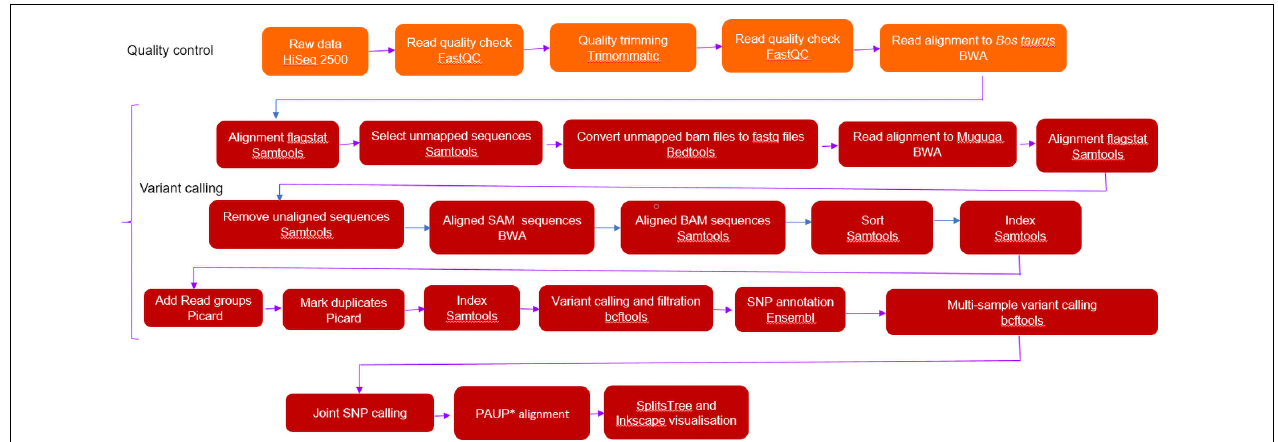
FIGURE 1 | Sequential analysis workflow used for whole genome studies of Theileria parva . SplitsTree and Inkscape